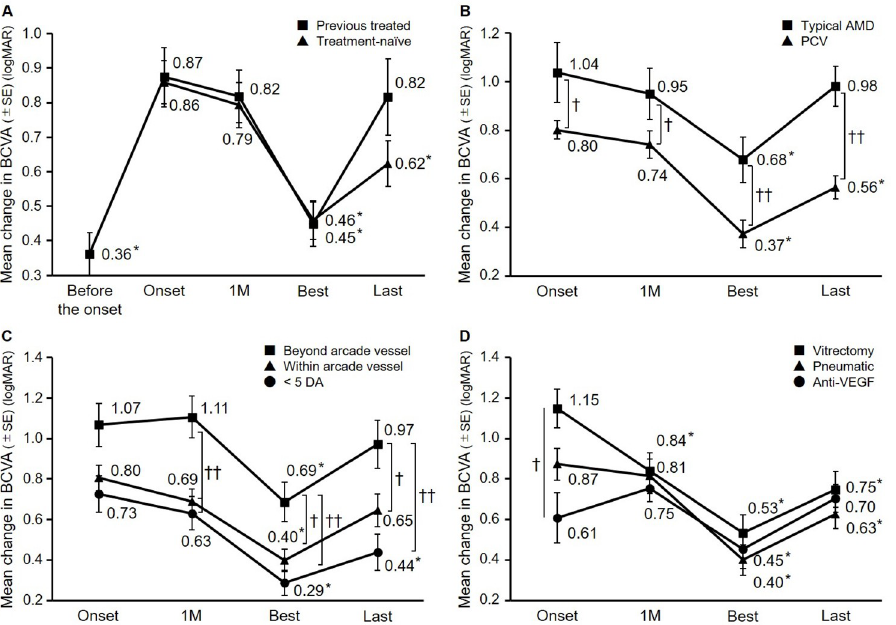
Fig 4. The changes in the mean Best-Corrected Visual Acuity (BCVA). A: In the treatment-na ï ve cases, the final VA improved significantly compared to the onset of the submacular hemorrhages (SMHs) ( � P < 0.01, paired t-test), while in the previously treated cases, the VA deteriorated significantly as a result of the SMHs and did not improve after treatment. B: In eyes with polypoidal choroidal vasculopathy (PCV), the final VA improved significantly compared to that at the onset of the SMH ( � P < 0.01, paired t-test), in eyes with typical age-related macular degeneration (AMD), the final VA was unchanged from that at the onset of the SMH. The mean BCVA in eyes with PCV was significantly better than in eyes with typical AMD at all time points († P < 0.05, †† P < 0.01 unpaired t-test). C: Regarding all SMH sizes, the VA improved once, while only the SMHs smaller than 5 disc areas (DA) maintained the VA improvement ( � P < 0.01, paired t-test), The BCVA in eyes with SMHs that extended beyond the arcade vessel was worse compared with other groups at all time points after intervention. († P < 0.05, †† P < 0.01 Bonferroni test). D: In eyes treated with vitrectomy or pneumatic displacement, the BCVA improved at the final visit but remained unchanged in eyes treated with anti-VEGF monotherapy ( P < 0.01, paired t-test). The VAs at the onset of SMHs were significantly better in eyes with treated with anti-VEGF monotherapy than vitrectomy. The final VAs did not differ significantly among the three groups. Best = at the visit with the highest BCVA recorded; Last = at the last visit; SE = standard error; M = month; Pneumatic = pneumatic displacement; logMAR = logarithm of the minimum angle of